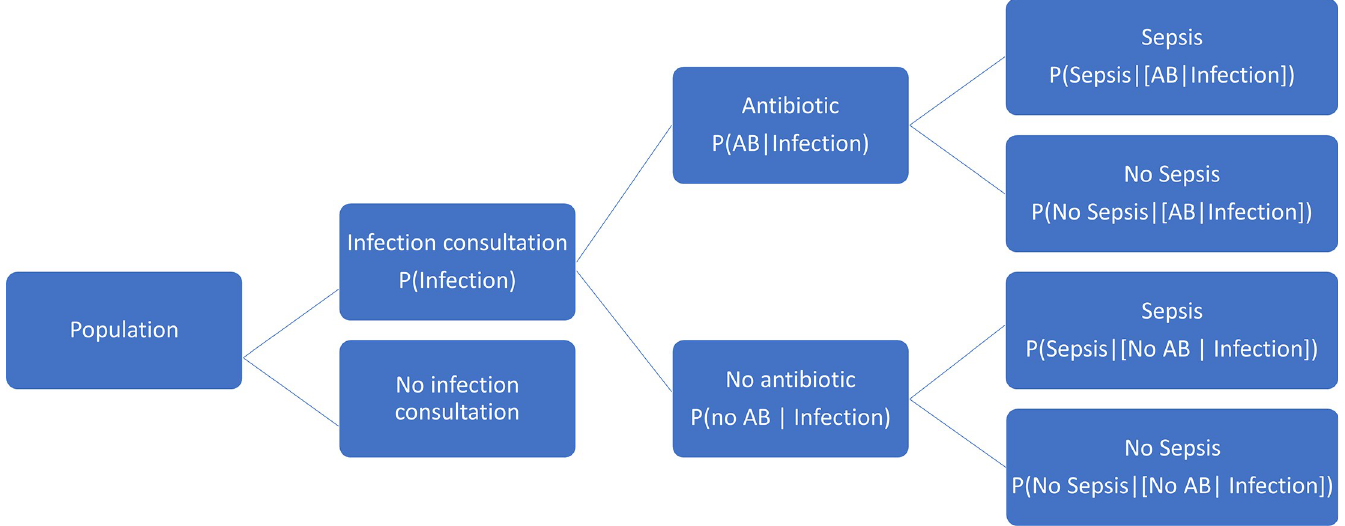
Fig 1. Decision tree showing the probability of a patient consulting for an infection, being prescribed an antibiotic at that consultation, and developing sepsis. Please refer to Table 1 for explanation of abbreviations. AB, antibiotic; P, probability.